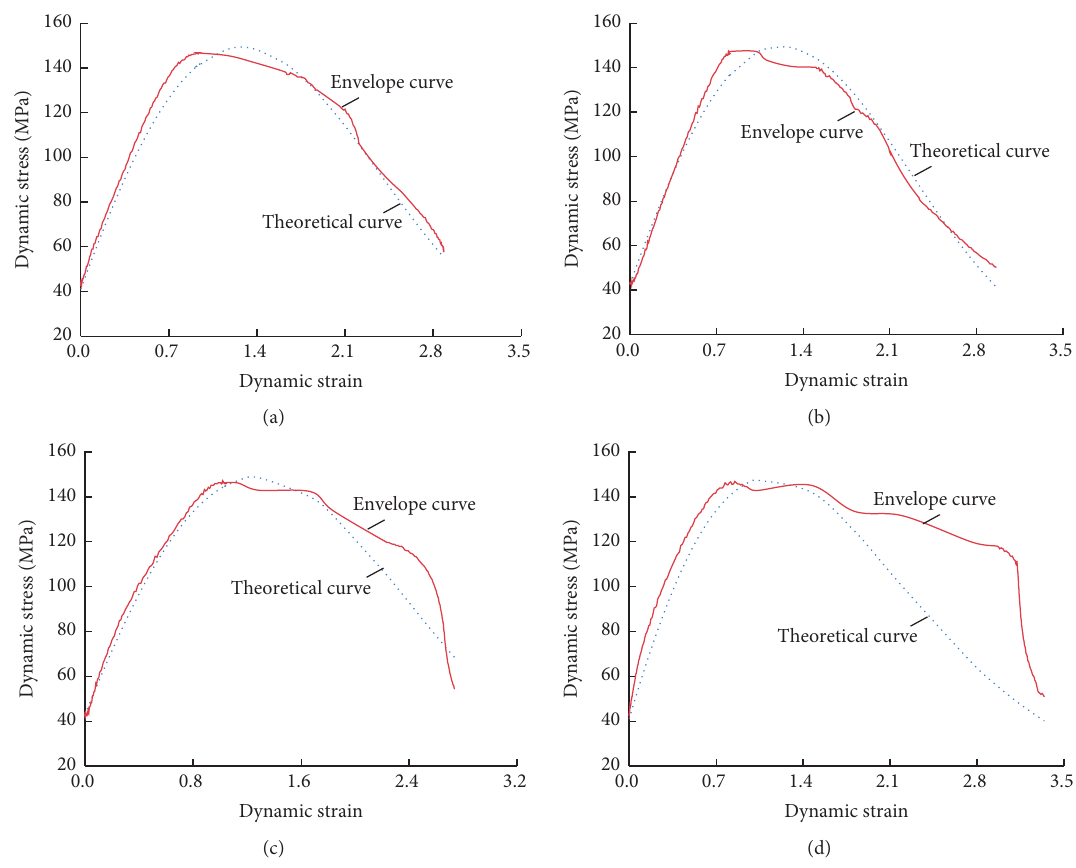
Figure 12: The comparison diagram of theoretical and experimental envelope curves of stress-strain under the pre-added axial compression of 85MPa (a) axial pressure unloading rate is 0.5MPa/s. (b) axial pressure unloading rate is 1.0MPa/s. (c) axial pressure unloading rate is 1.5MPa/s, and (d) axial pressure unloading rate is